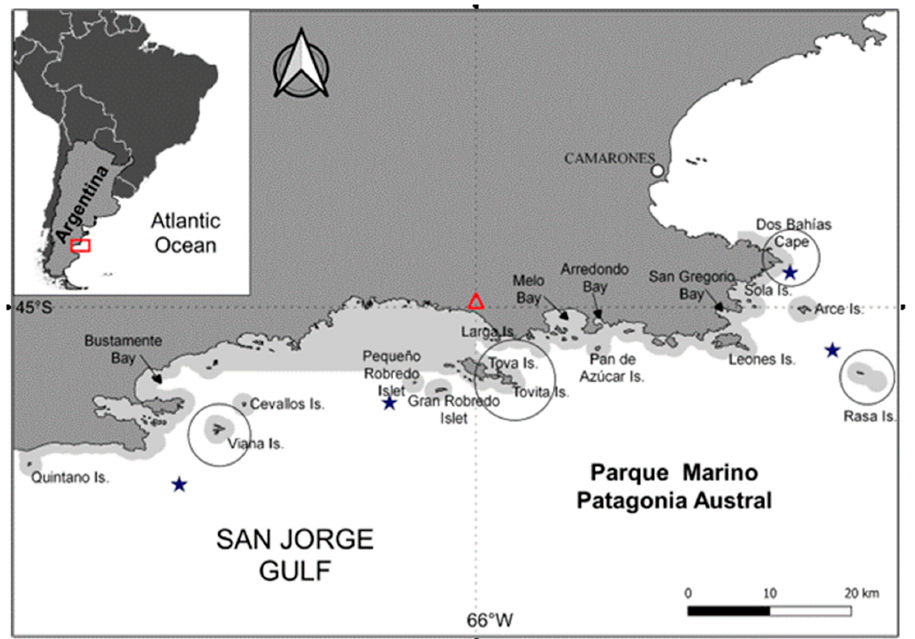
Figure 1. Geographical location of Golfo San Jorge. The Parque Interjurisdiccional Marino-Costero Patagonia Austral (PIMCPA) is represented as the hatched area. Red triangle denotes wind node, blue stars show the localization of tidal current nodes, and empty circles signal the mean position of structures described in detail in Section 4.2.